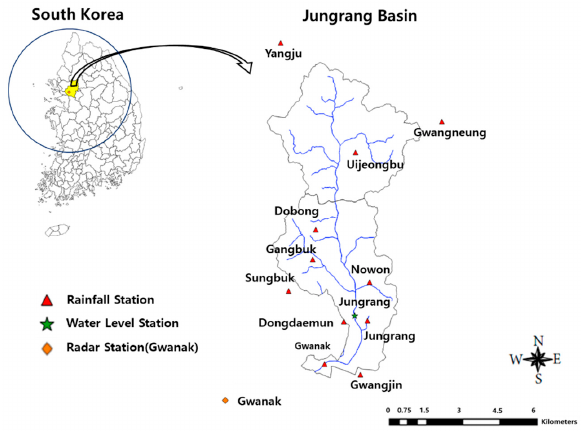
Figure 2. Water level and rainfall stations in Jungrang Basin.